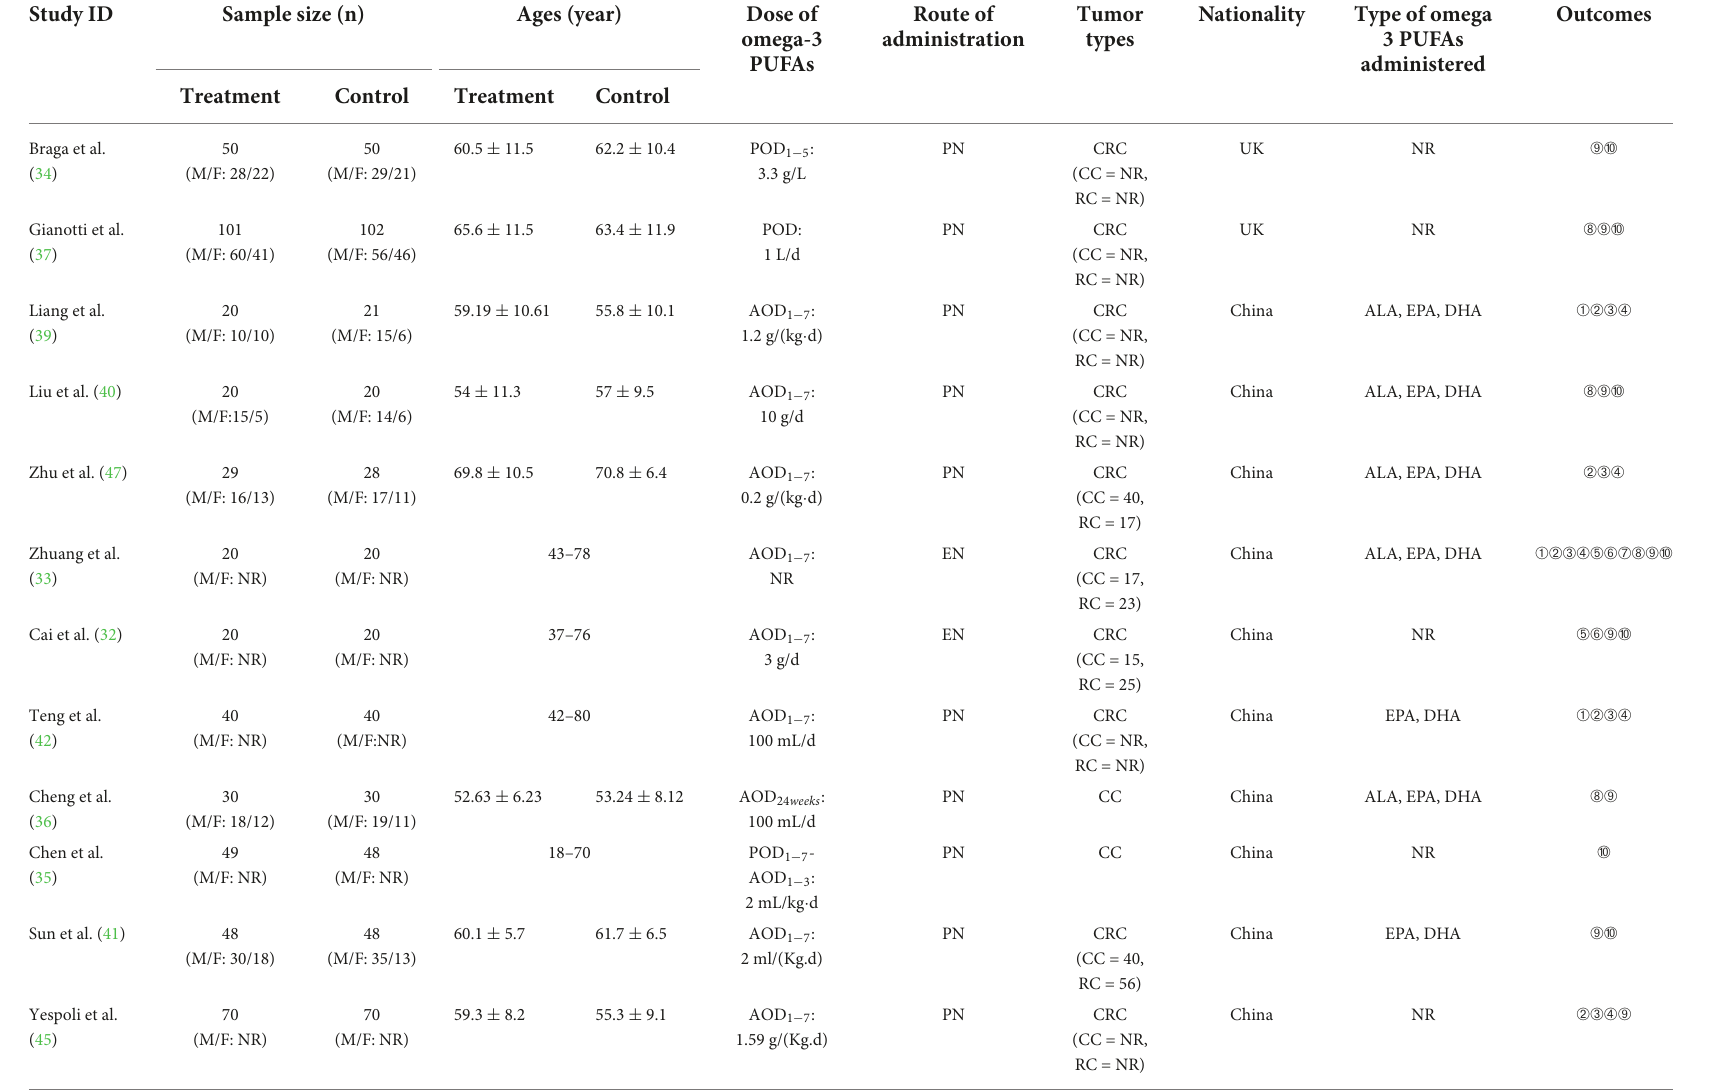
TABLE 1 The main features of the included studies